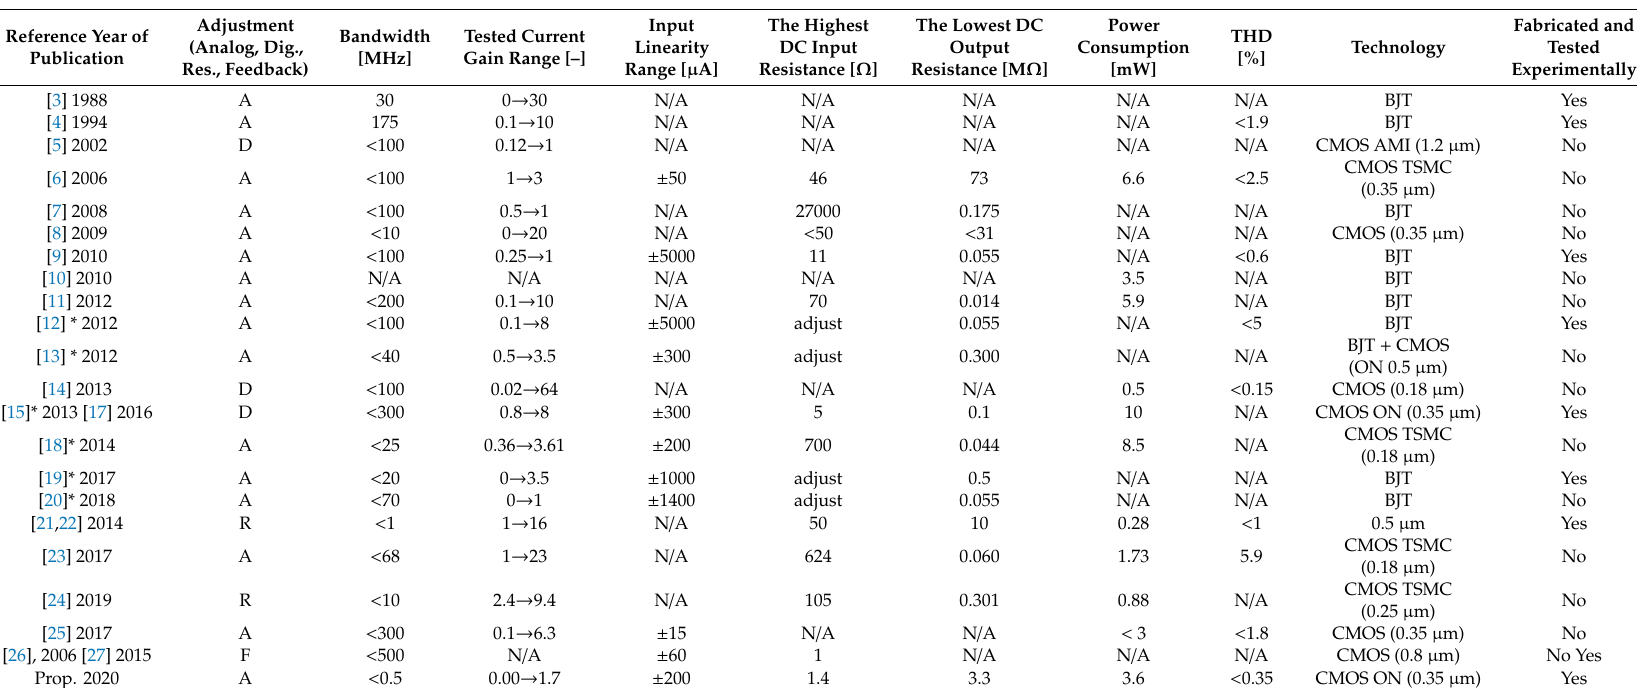
Table 1. Comparison of features of adjustable current amplifiers or active devices including transfer response of adjustable current amplifier reported in recent